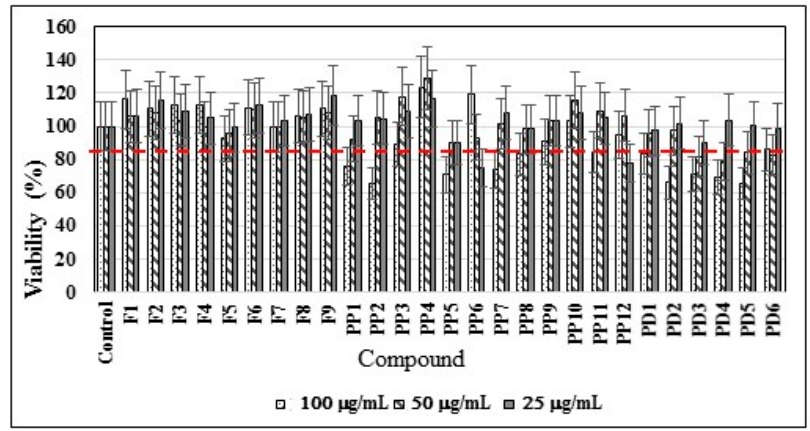
Figure 2. The effects of the compounds evaluated on the viability of K. pneumoniae . Minimum viability 85% growth was established respect to the found in the control medium without substances. See structure code in Figure 1.